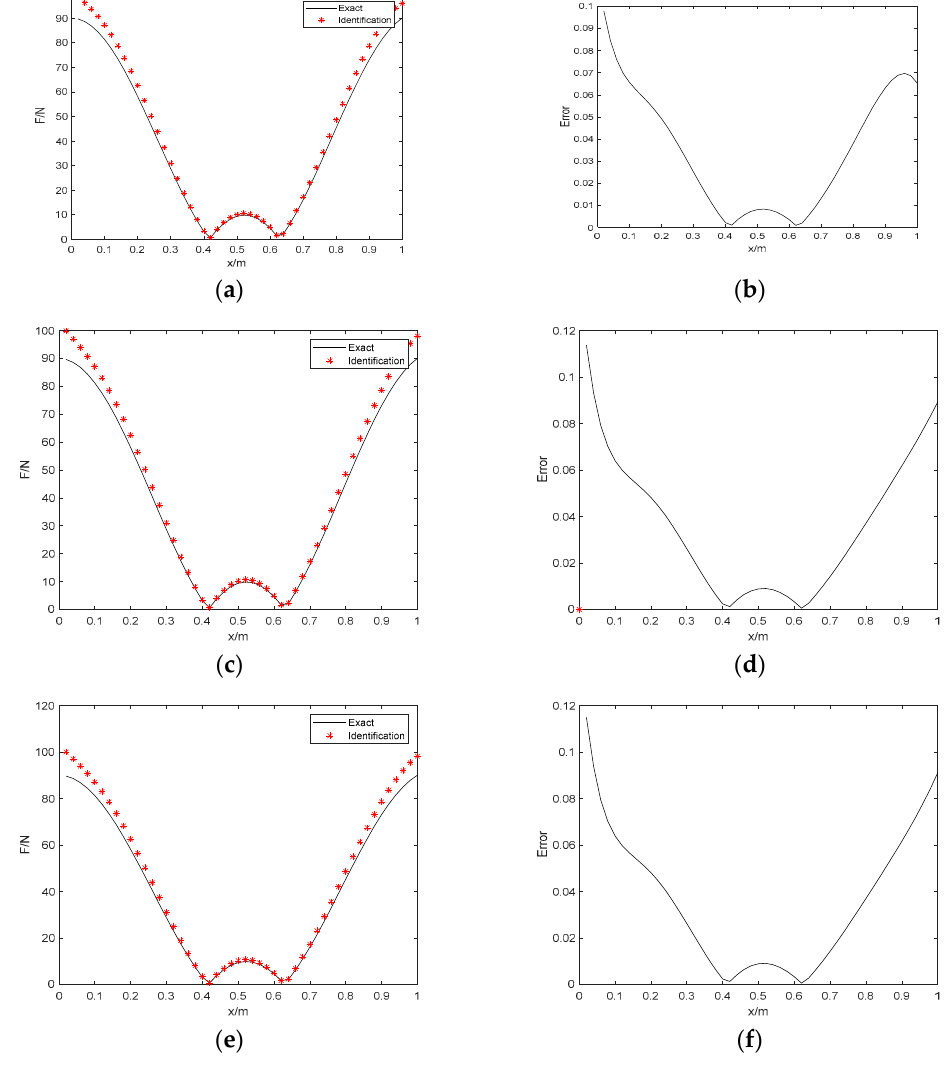
Figure 8. The identification results with 10% noise. ( a ) Proposed method; ( b ) identification error; ( c ) Tikhonov with L − curve regularization; ( d ) identification error; ( e ) Tikhonov with GCV regulariza- tion; ( f ) identification error.